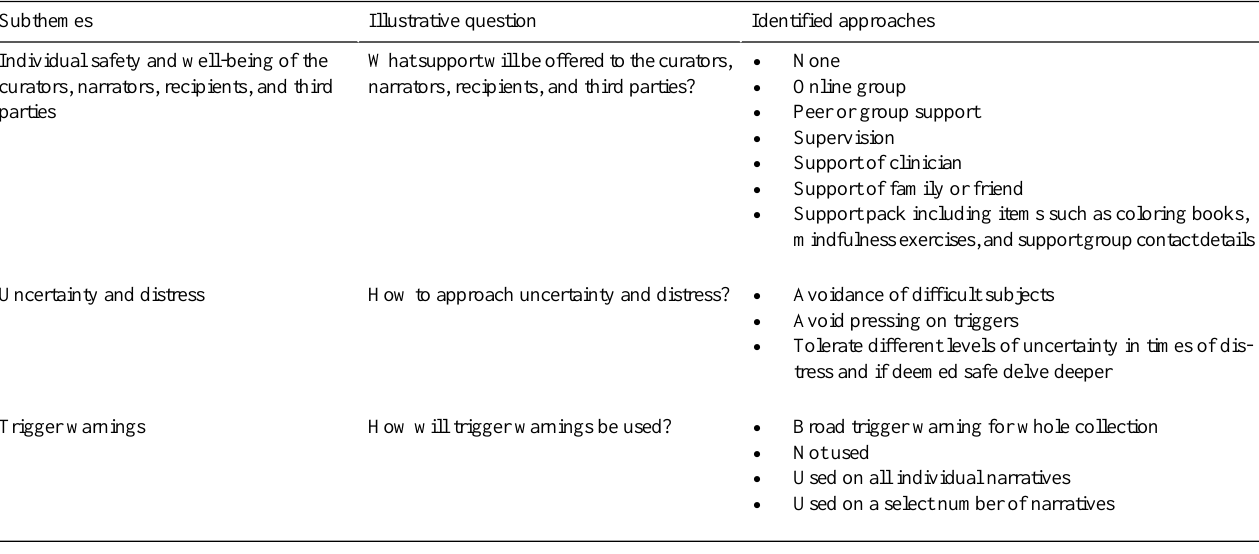
Table 7. Safety and well-being in the curation of